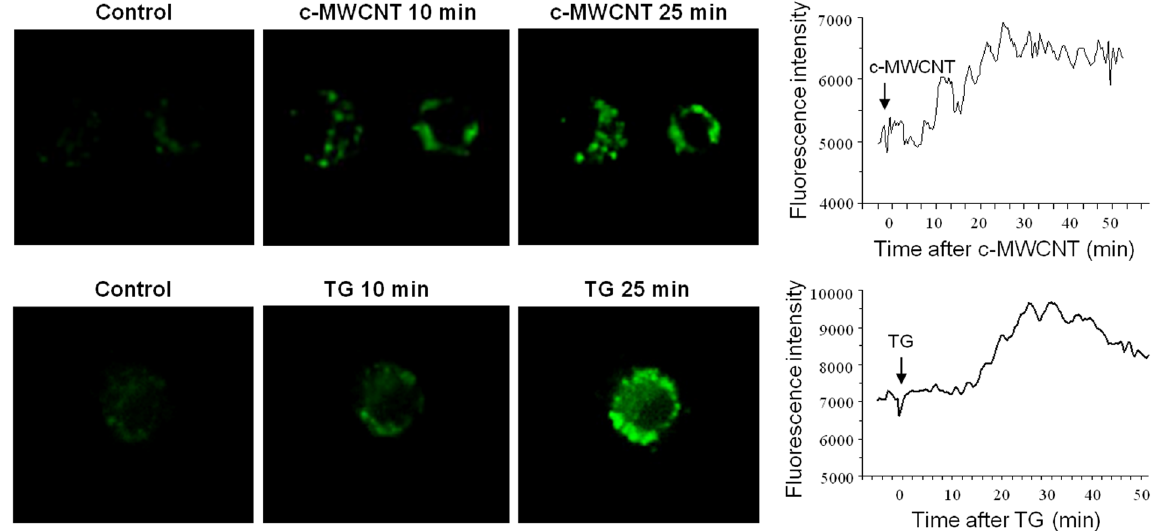
Figure 3. Confocal microscopy showing the calcium-mobilizing effects of c-MWCNTs ( upper row ) and the positive control drug TG ( lower row ) in RAW264.7 macrophages. Note that both c-MWCNTs and TG increased the intracellular free calcium level ([Ca 2 + ] i ) of RAW264.7 cells.